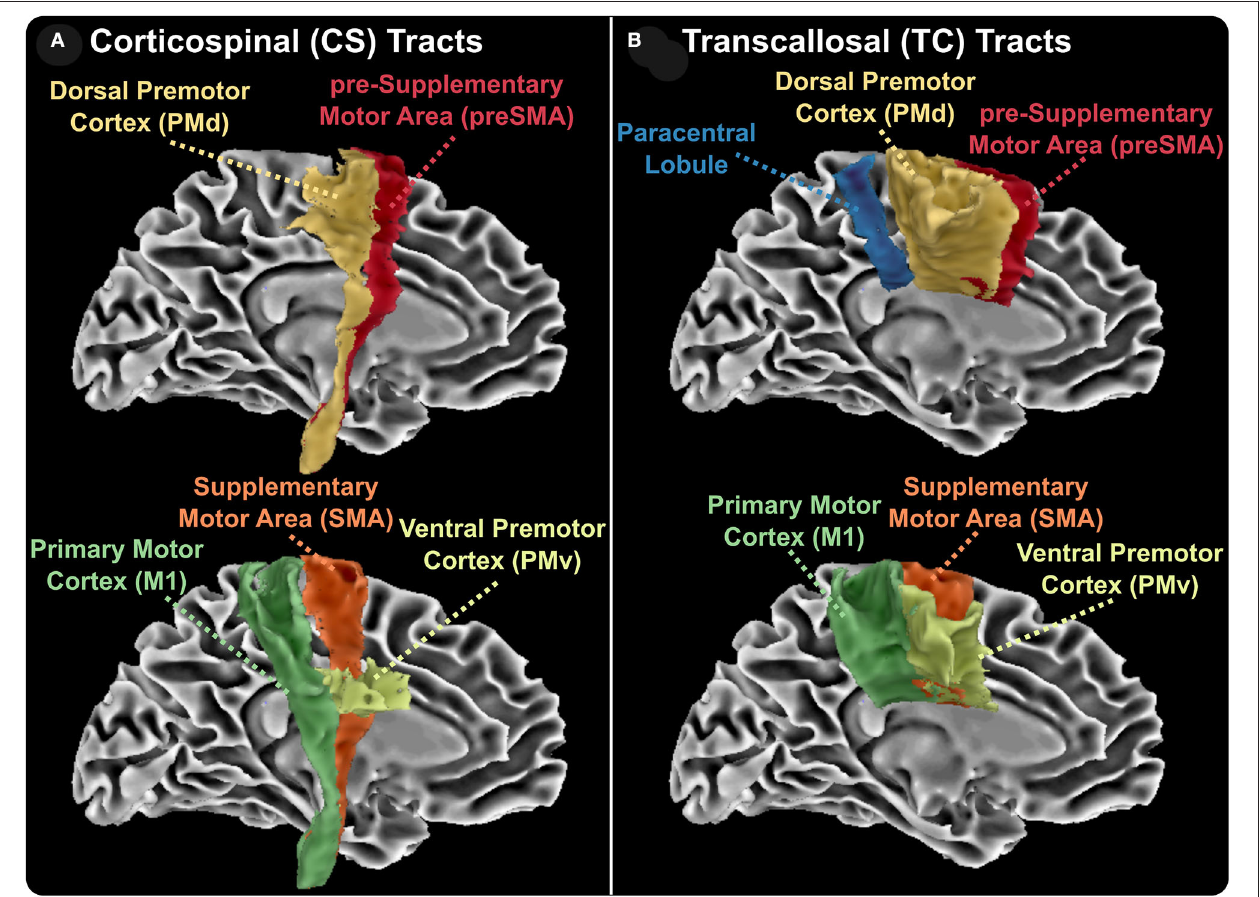
FIGURE 1 | Reconstructed white matter tracts. Corticospinal (CS, A ) and transcallosal (TC, B ) aspects of reconstructed white matter tracts. CS and TC tracts include the ventral premotor cortex, the dorsal premotor cortex, the presupplementary area, the supplementary motor area, and primary motor cortex. TC tracts also include the interhemispheric bundles connecting the two paracentral